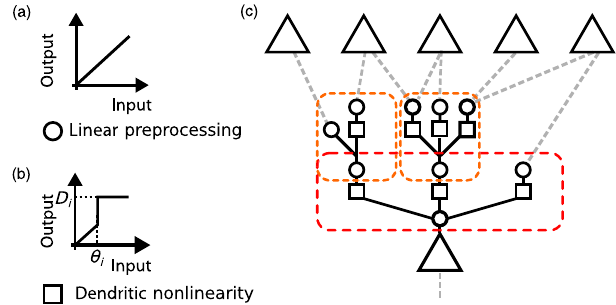
FIG. 8. Neuron model with multiple layers of dendritic branches and nonadditive processing. Similarly to Fig. 1, differ- ent steps of (a) linear and (b) nonadditive dendritic input processing are represented by circles and squares, respectively. A neuron with two levels of nonadditive dendritic branches is displayed in (c). As is exemplarily shown, the numbers of sub- branches may vary (at each level and between branches), and there may be synaptic input to linear and nonlinear dendrites at all